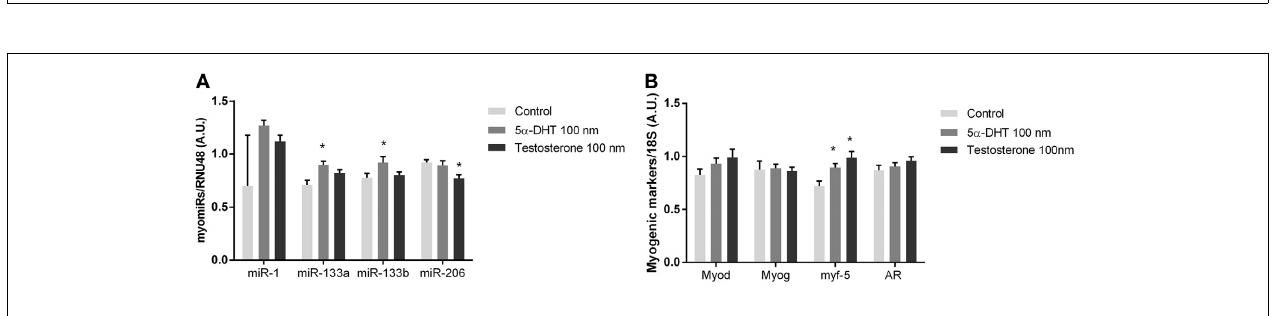
FIGURE 5 | myomiR expression in testosterone treated human muscle cells. myomiR expression in differentiated human primary myocytes in response to 100nM testosterone ( n = 4), and 5 α -DHT ( n = 4). Control cultures ( n = 4) were added DMSO in same concentrations as testosterone and 5 α -DHT stimulated myocytes. miR-133a/b was upregulated in response